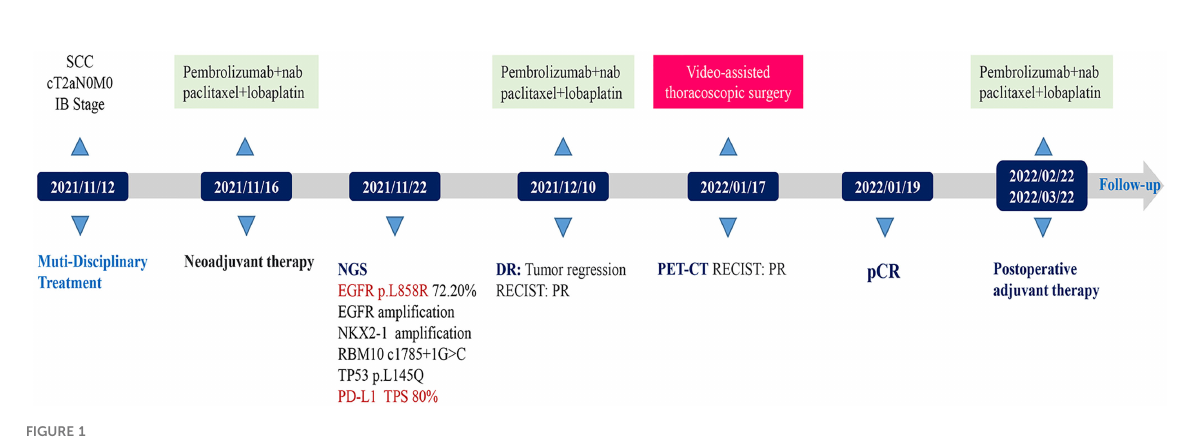
FIGURE 1 Treatment timeline of the